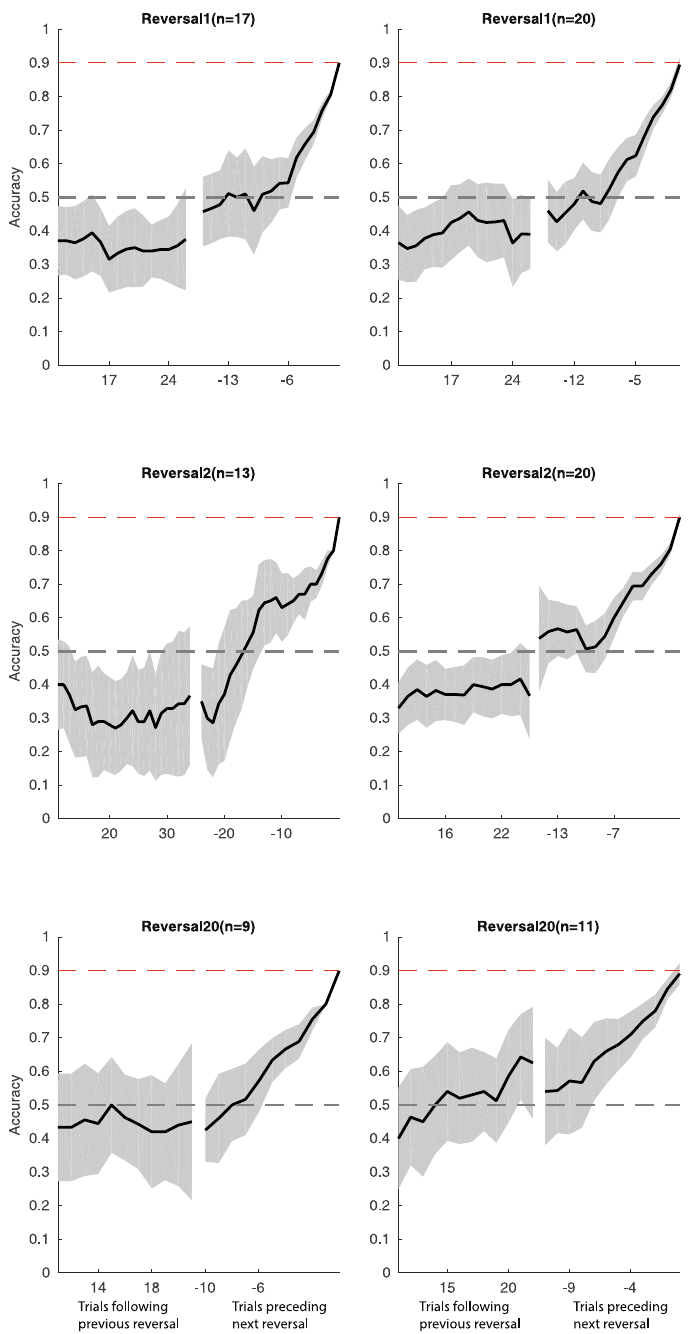
Figure 3. Learning curves in first (top panel), second (middle panel) and 20 th reversal (bottom panel) for captive (left panel) and wild birds (right panel). For each graph, the black line and grey shaded area represents sliding window accuracy ( + / − 95% bootstrapped CI) computed on a 10 trial sliding window and is plotted for early trials directly following previous reversal (left part of the curve) and late trials preceding next reversal (right part of the curve). Learning criterion is reached when a bird performed 9 correct trials out of 10 successive trials (0.9; top dashed line). As birds required a different number of trials to reach the learning criterion, learning curves are plotted only for trials performed by at least half of the birds who completed that reversal, aligned on beginning (trials following previous reversal, positive value on x axis) or end (trials preceding next reversal, negative value on x axis) of the reversal session. Middle dashed line represents chance